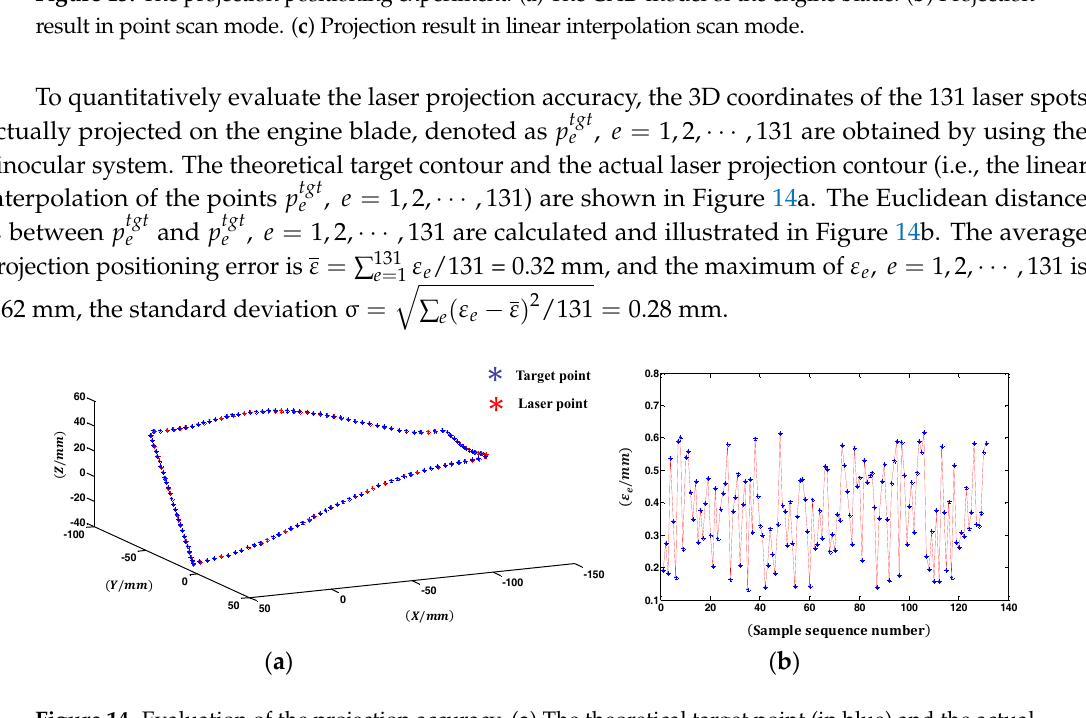
Figure 14. Evaluation of the projection accuracy. ( a ) The theoretical target point (in blue) and the actual laser projection point (in red). ( b ) Projection errors of the 131 discrete points.